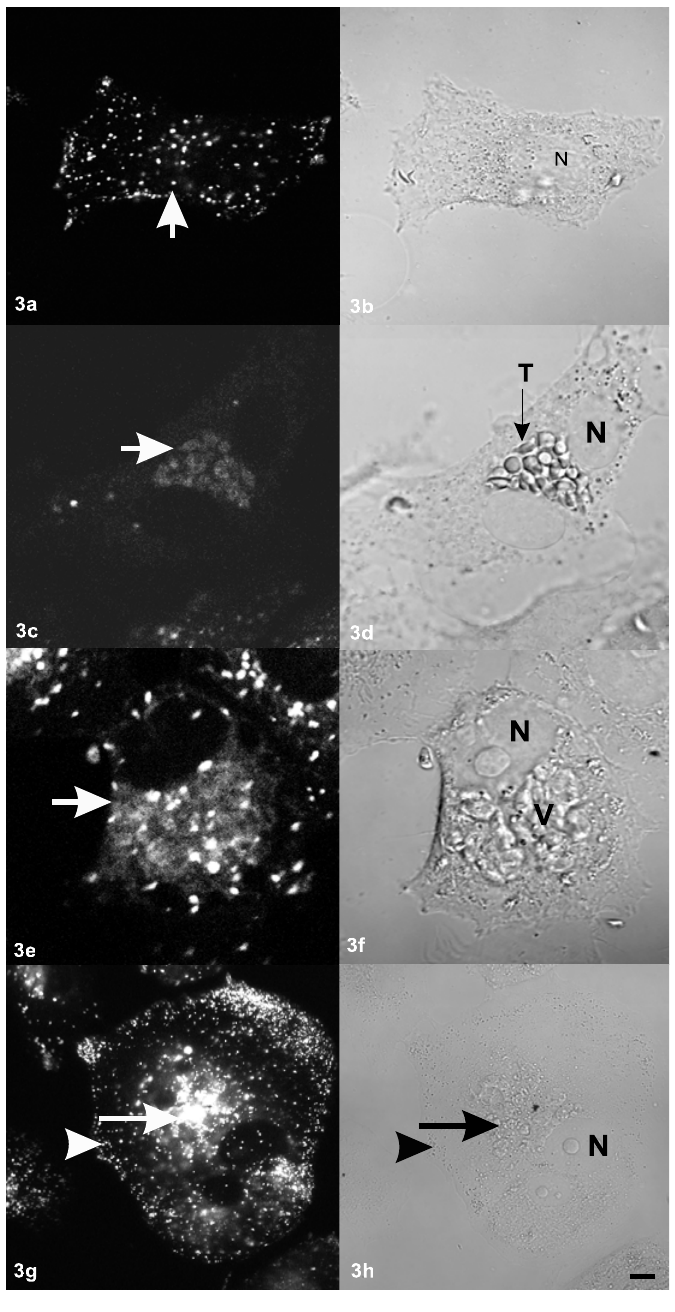
Fig. 3 – Confocal laser scanning microscopy of infected in the presence of Lyso Tracker red (50nm) for 30 minutes. Punctual fluorescence could be observed at the cytoplasm in untreated host cell (fig. 3a, b – arrowhead). However, a progressive fluorescence inside PV containing tachyzoites was observed after incubation for 12h (fig. 3c, d – arrow), 24h (fig. 3e, f – arrow) or 48h (fig. 3g, h – arrow) in presence of HU as indicative PV-lysosomes fusion. Tachyzoytes: T; Nucleus: N; Parasitophorous vacuole: V. Bar: 5 µ m.